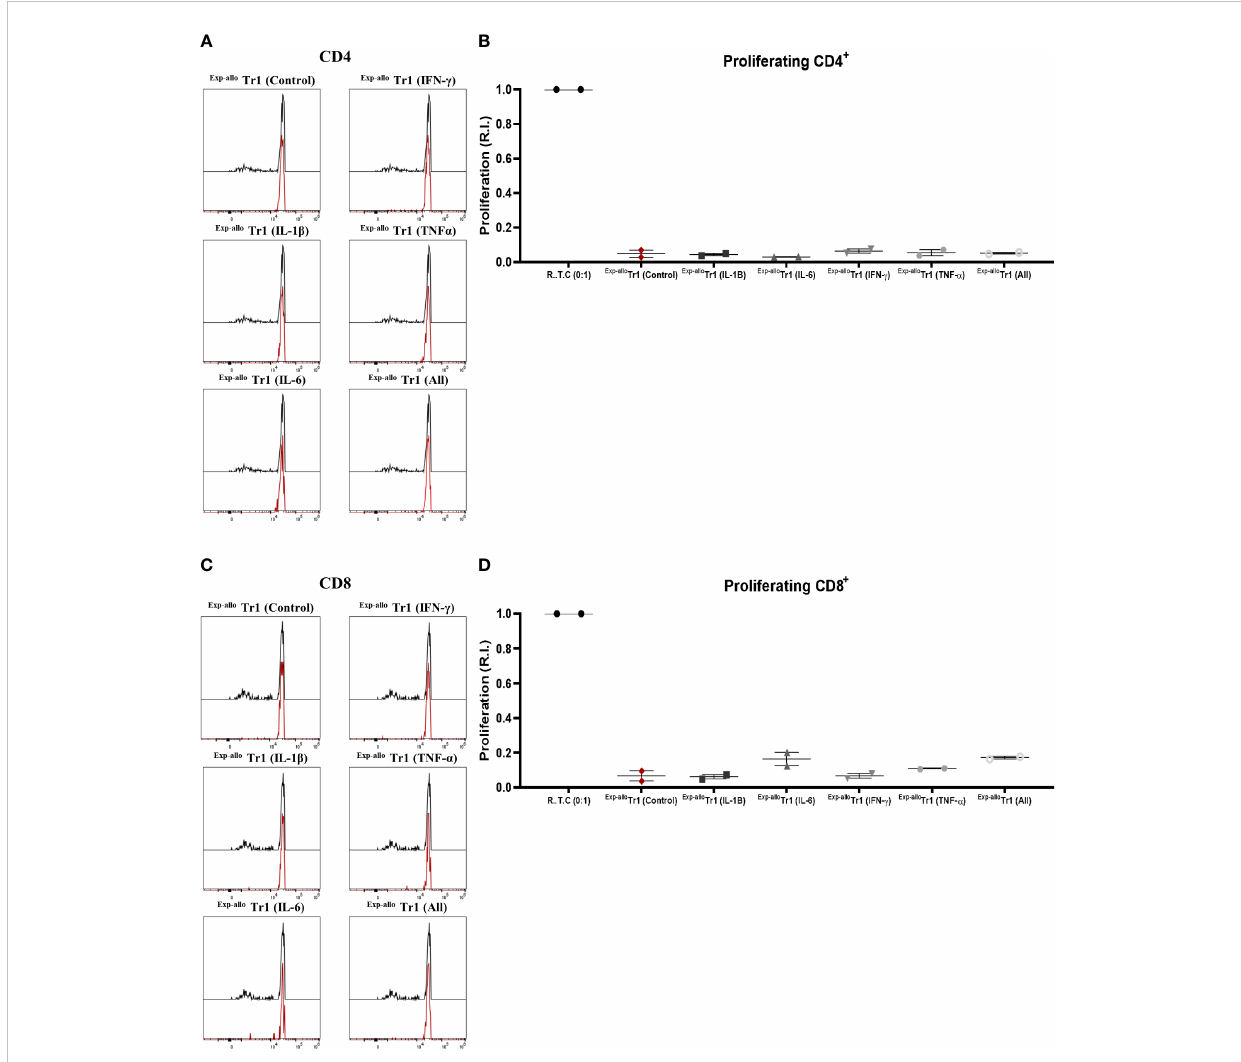
FIGURE 11 Exp-allo Tr1 cells maintain their suppressive function after stimulation in an in fl ammatory microenvironment. Exp-allo Tr1 activated in presence or absence of pro-in fl ammatory cytokines (IFN- g , IL-6, IL-1 b , TNF- a or all together) were co-cultured with conventional CD3 + R.T.C. (labeled with CFSE) at 1:1 ratio and stimulated with allogeneic moDC from their respective donors, on day 4 of co-culture. (A – D) Exp-allo Tr1 ef fi ciently suppressed the proliferation of both CD4 + (A, B) and CD8 + (C, D) R.T.C. after being activated in presence of IL-1 b , IL-6, IFN- g , TNF- a or all together (n= 2). All experiments were performed in duplicates. Data are representative of two independent experiments. The results are shown as mean ± SEM. Statistical analysis was performed using the unpaired-t test or one sample t and Wilcoxon